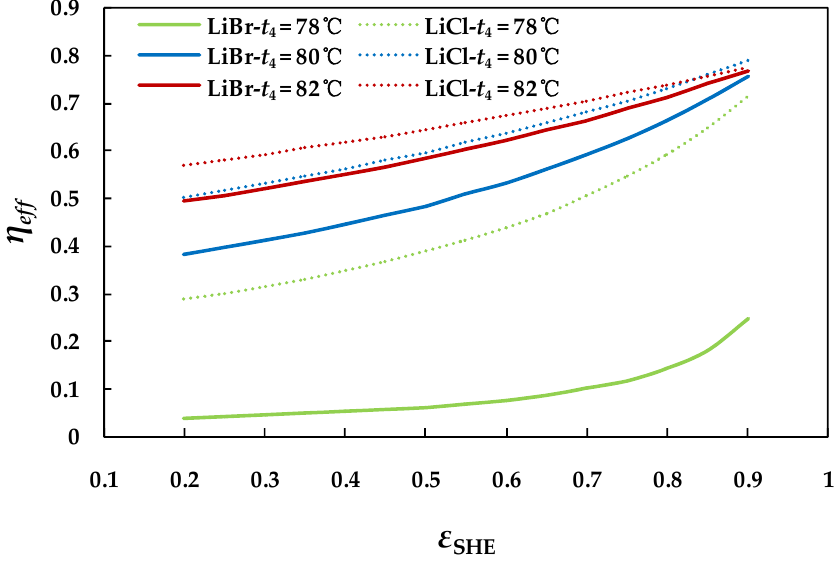
Figure 12. Heat exchanger e ff ectiveness impact on the e ffi ciency ratio of the absorption system under various generator temperature levels (78 ◦ C, 80 ◦ C, and 82 ◦ C) for the two working pairs ( t 1 = t 8 = 40 ◦ C , t 10 = 7 ◦ C, ε =